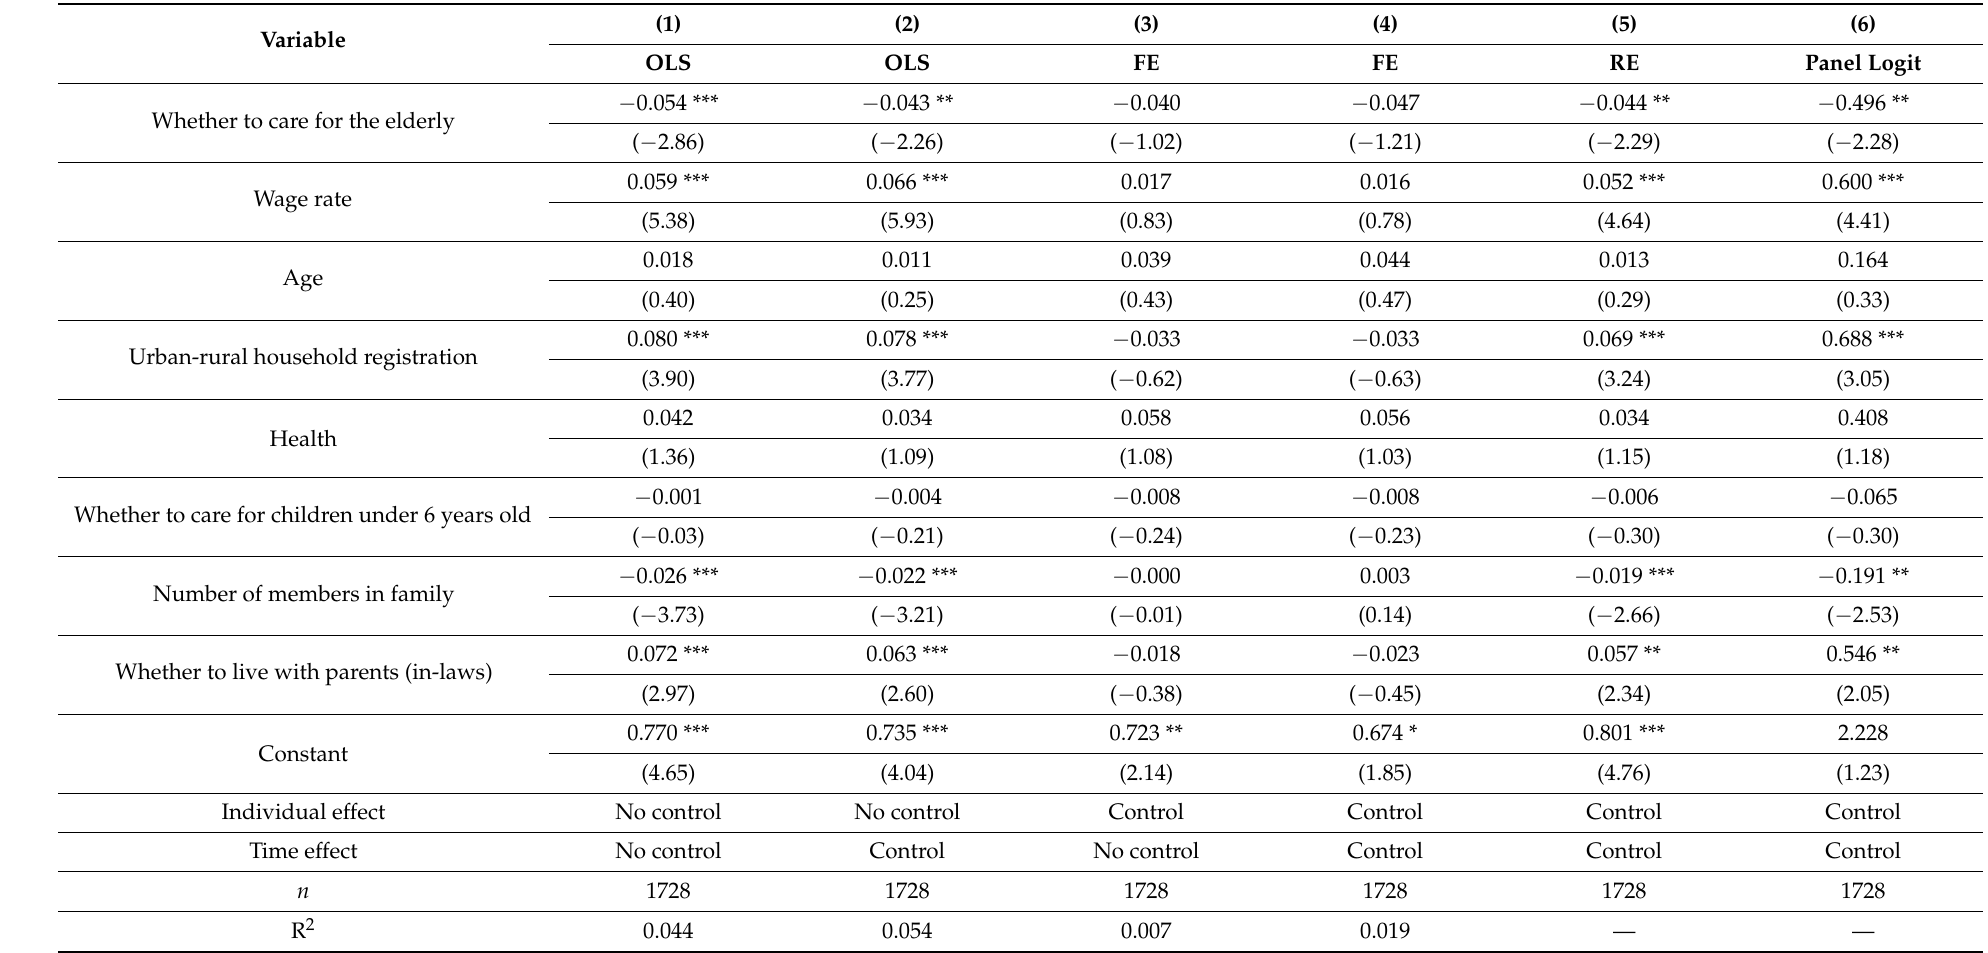
Table 3. Estimation results of the model